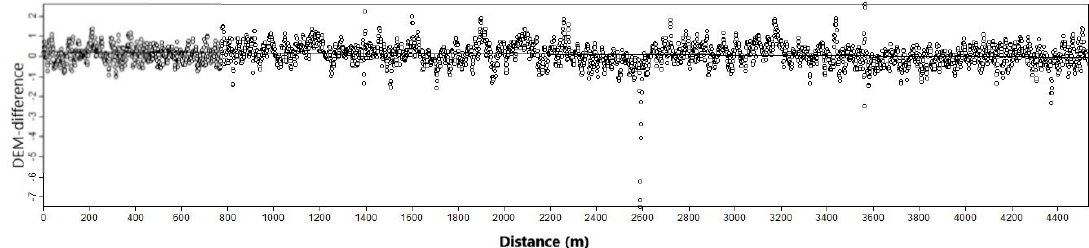
Figure 9. Profile 2, located east of the tongue of Khumbu glacier. The profile shows the surface differences in off-glacier terrain between the spring 2015 and autumn 2015 acquisitions from south to north.